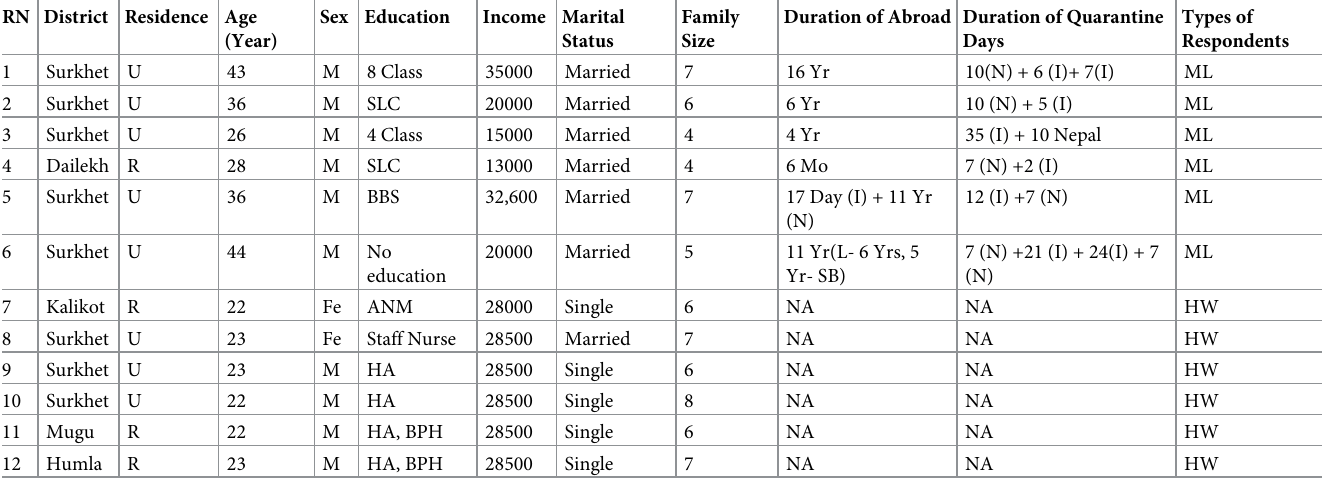
Table 5. Characteristics of participants in In Depth Interview (n =